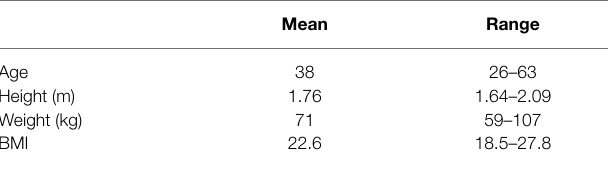
TABLE 1 | Participant characteristics for the study